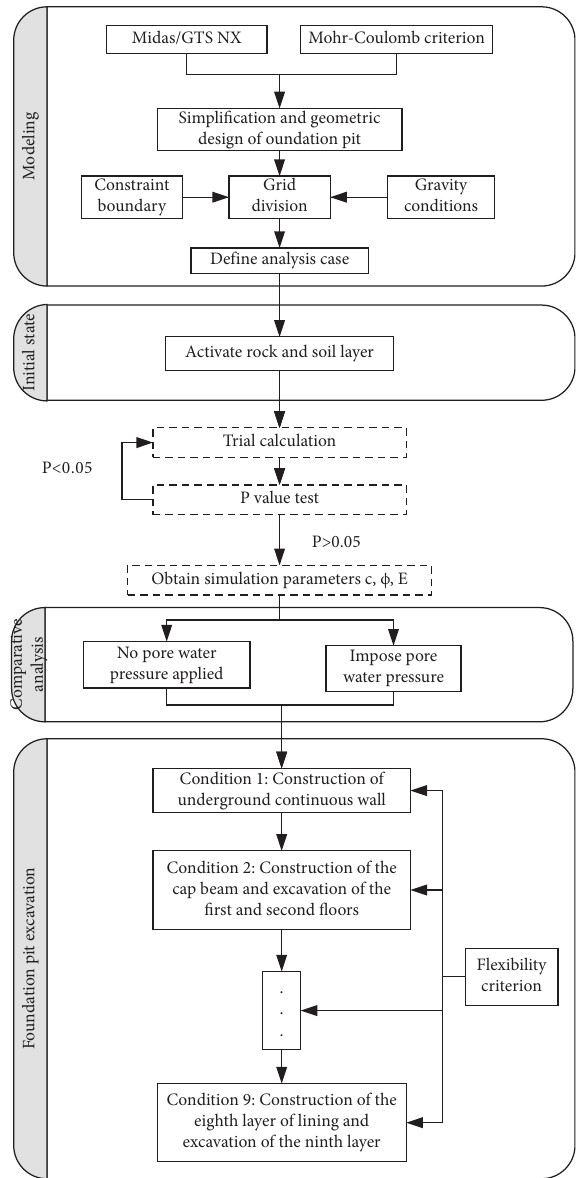
Figure 10: Flowchart of the modeling and calculation